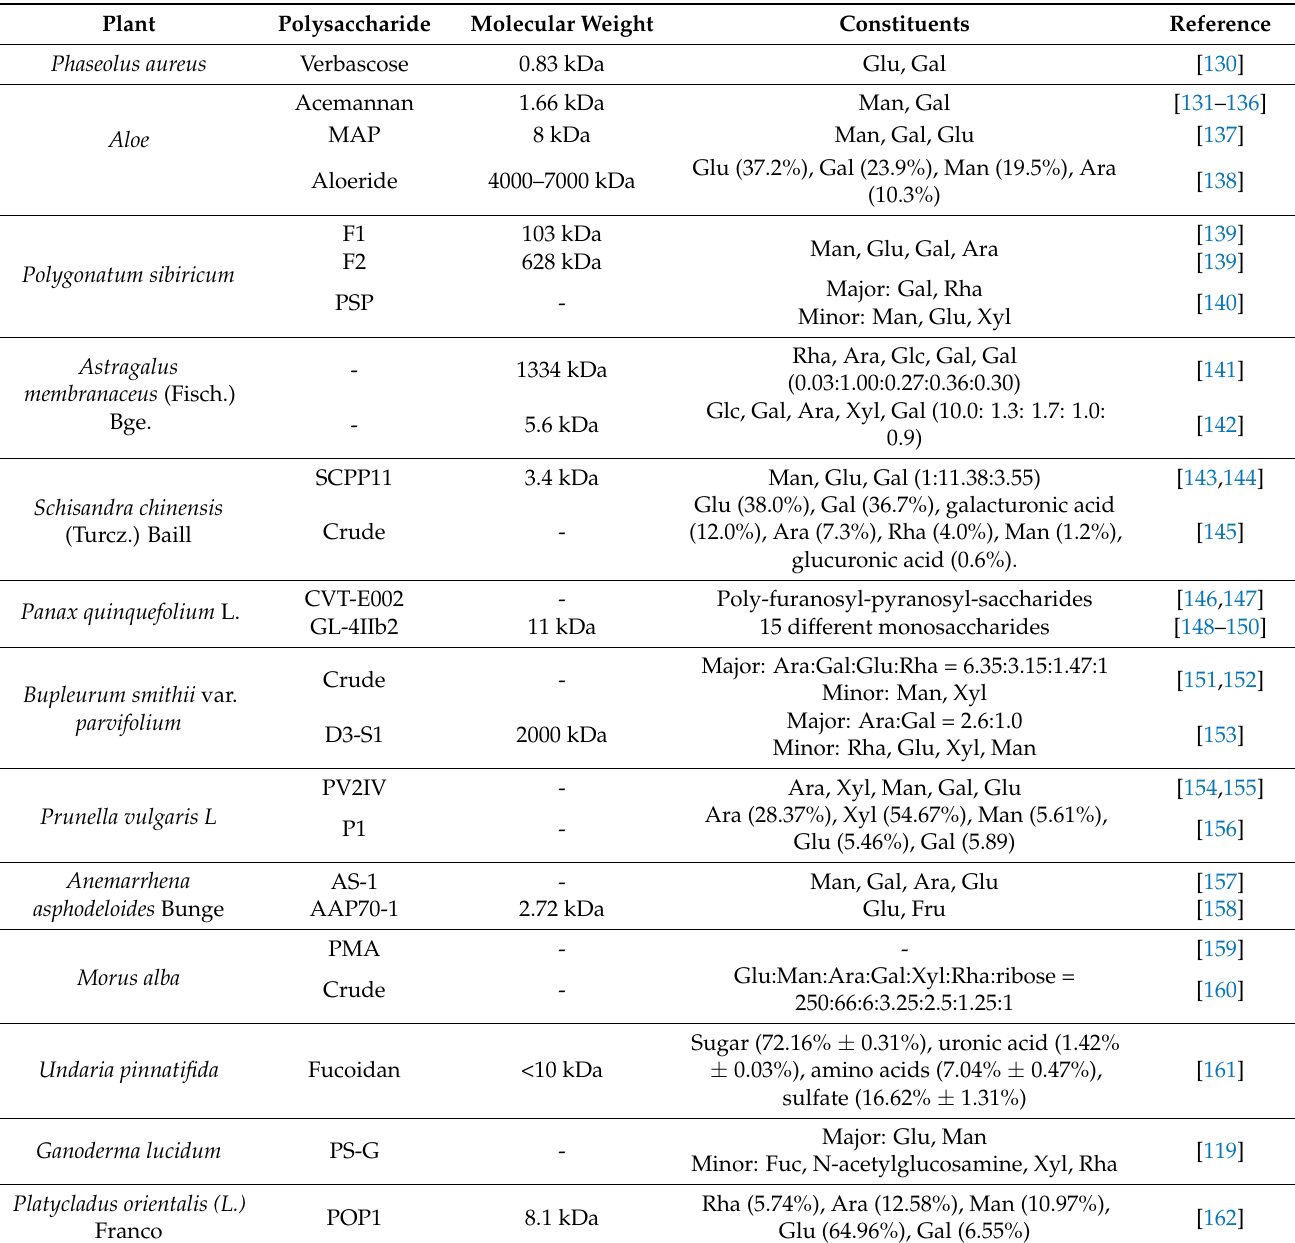
Table 3. Chemical details of